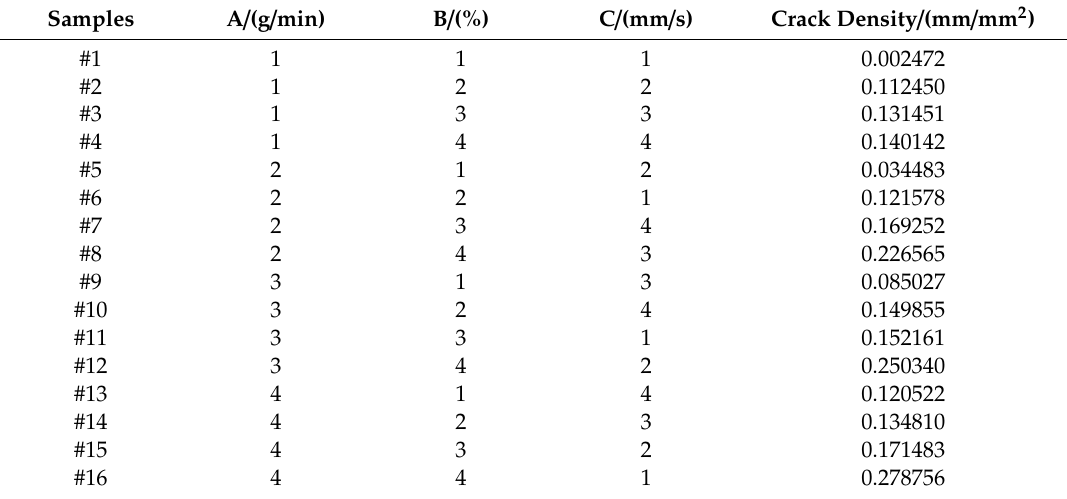
Table 4. Laser cladding results of the orthogonal testing.